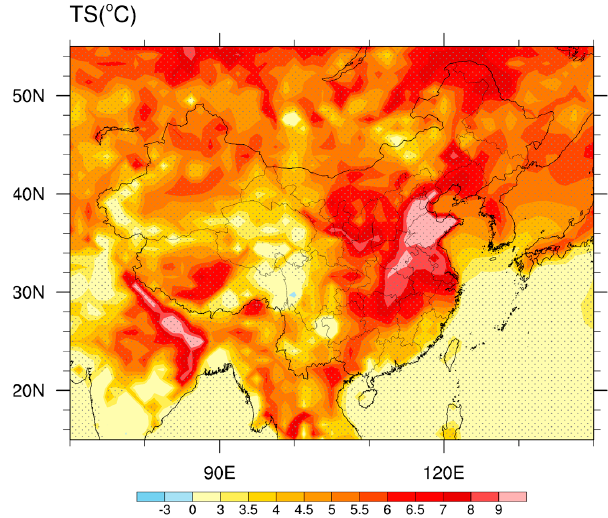
Figure 3. Mean summer daily maximum surface air temperature changes during the period 2071 − 2080 relative to 1991 − 2000. The values are statistically significant at the 95% confidence level in the stippling regions.